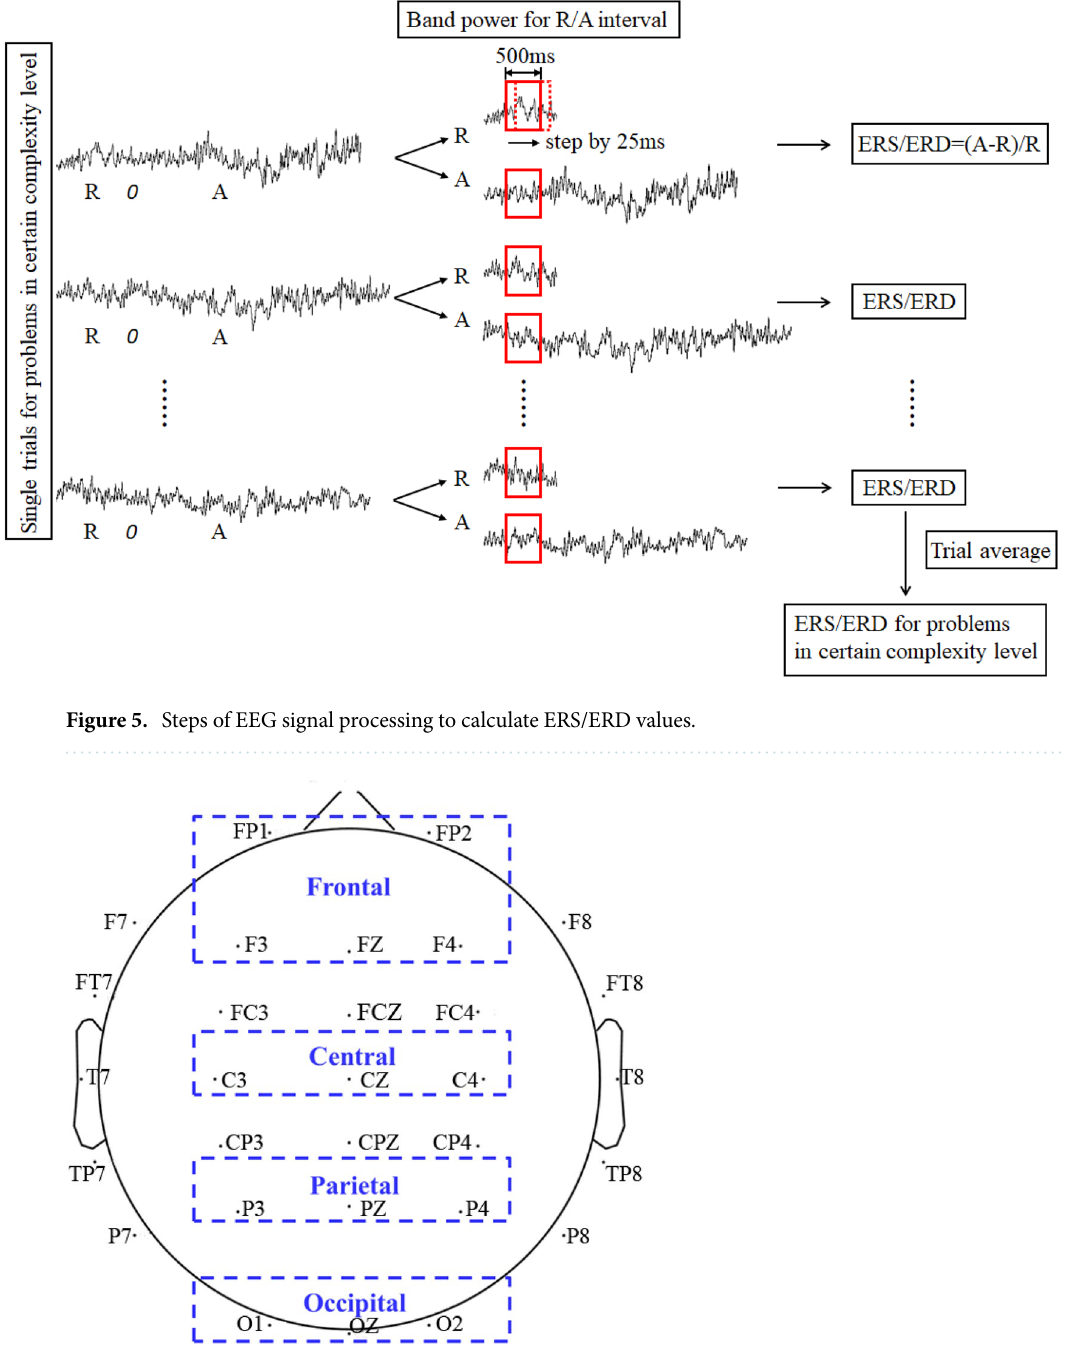
Figure 6. Division of the brain regions and their included electrodes for ERS/ERD calculation. Frontal (FP1, FP2, F3, Fz and F4), Central (C3, Cz and C4), Parietal (P3, Pz, and P4) and Occipital (O1, Oz, and